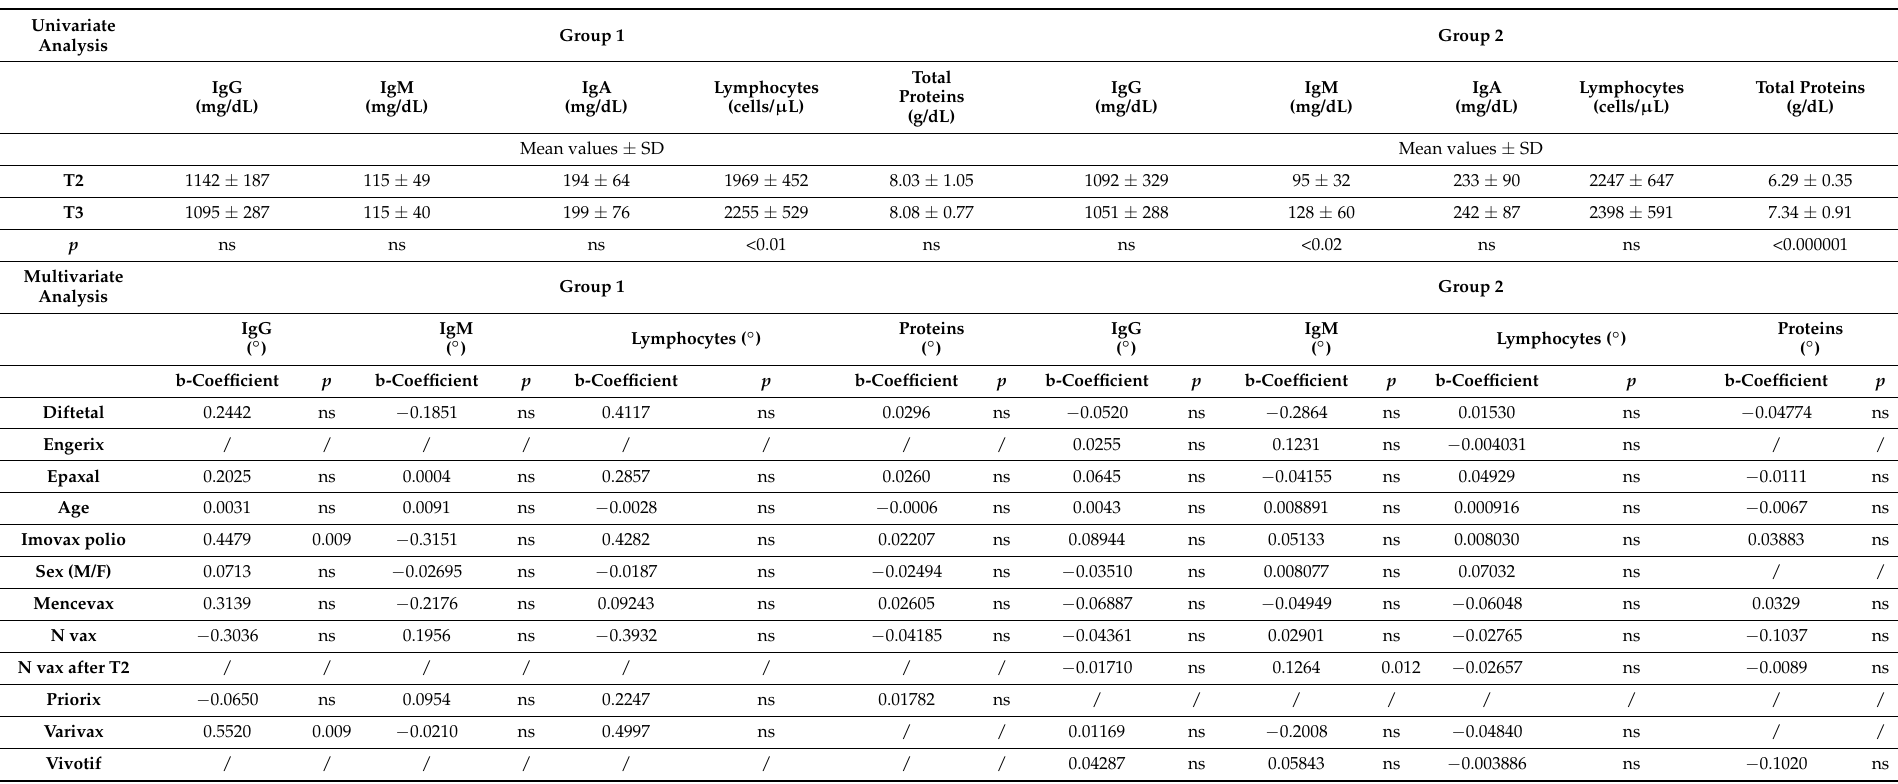
Table 2. Univariate analysis of mean values ± SD of peripheral blood lymphocytes, serum protein and immunoglobulin measures at two time points in group 1 and 2 subjects, and Multivariate analysis of demographic and immunization variables on lymphocytes, total proteins, IgM, and IgG levels in both military